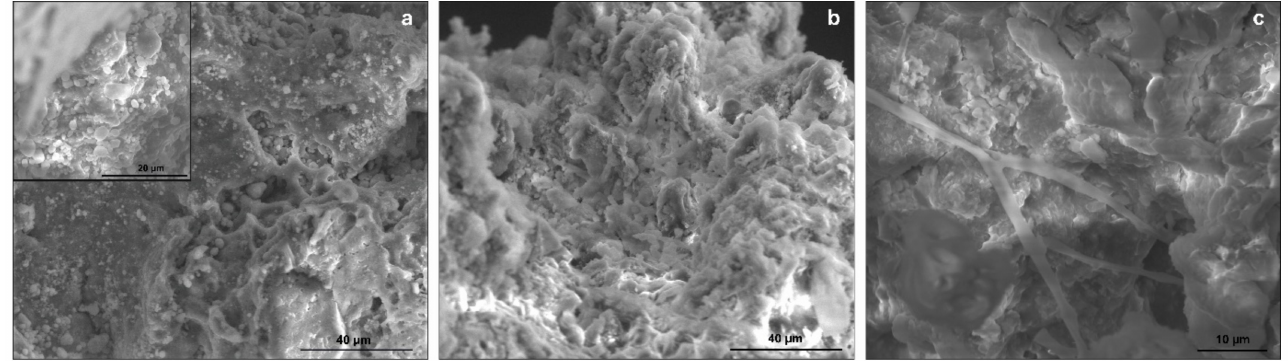
Figure 6. SEM images in secondary electron mode showing putative bacteria in the microcavities of the stone ( a ), a cyanobacterial biofilm ( b ) and fungal hyphae ( c